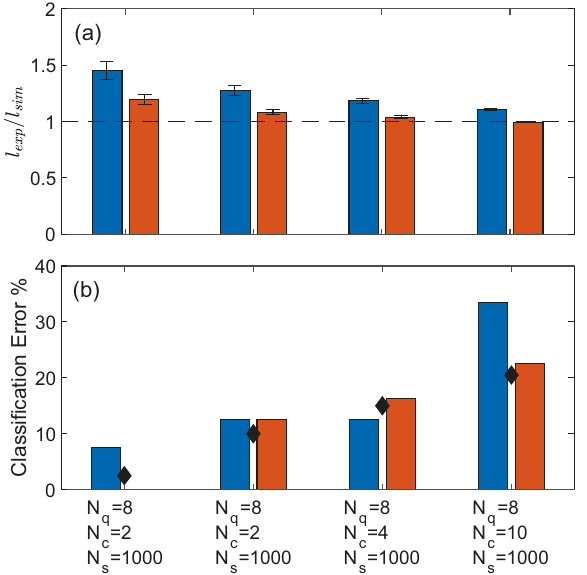
Fig. 4 MNIST data set. ( a ) Ratio of distance calculated from experiment vs simulator, and ( b ) classi fi cation of different down- scaled MNIST data sets. From left to right, the data sets were (i) 0 and 1 (40 samples), (ii) 2 and 7 (40 samples), (iii) 0 – 3 (80 samples) and (iv) 0 – 9 (200 samples). The diamonds show the accuracy of classical Nearest Centroid. The error bars in (a) correspond to the standard error in the ratio of distances for each dataset.